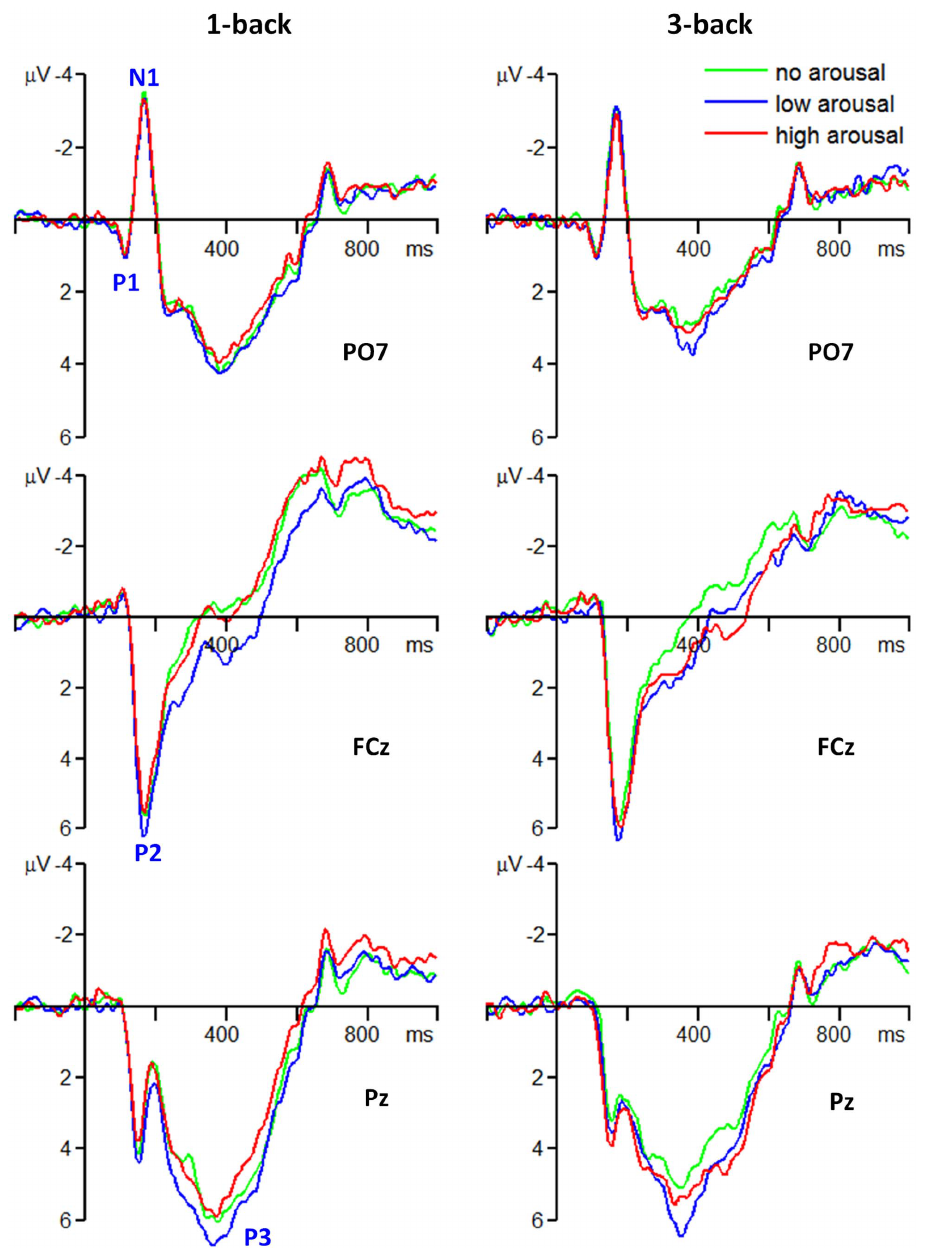
Figure 2. Grand average ERPs of the occipito-temporal P1 and N1, fronto-central P2, and parietal P3 components at typical electrode